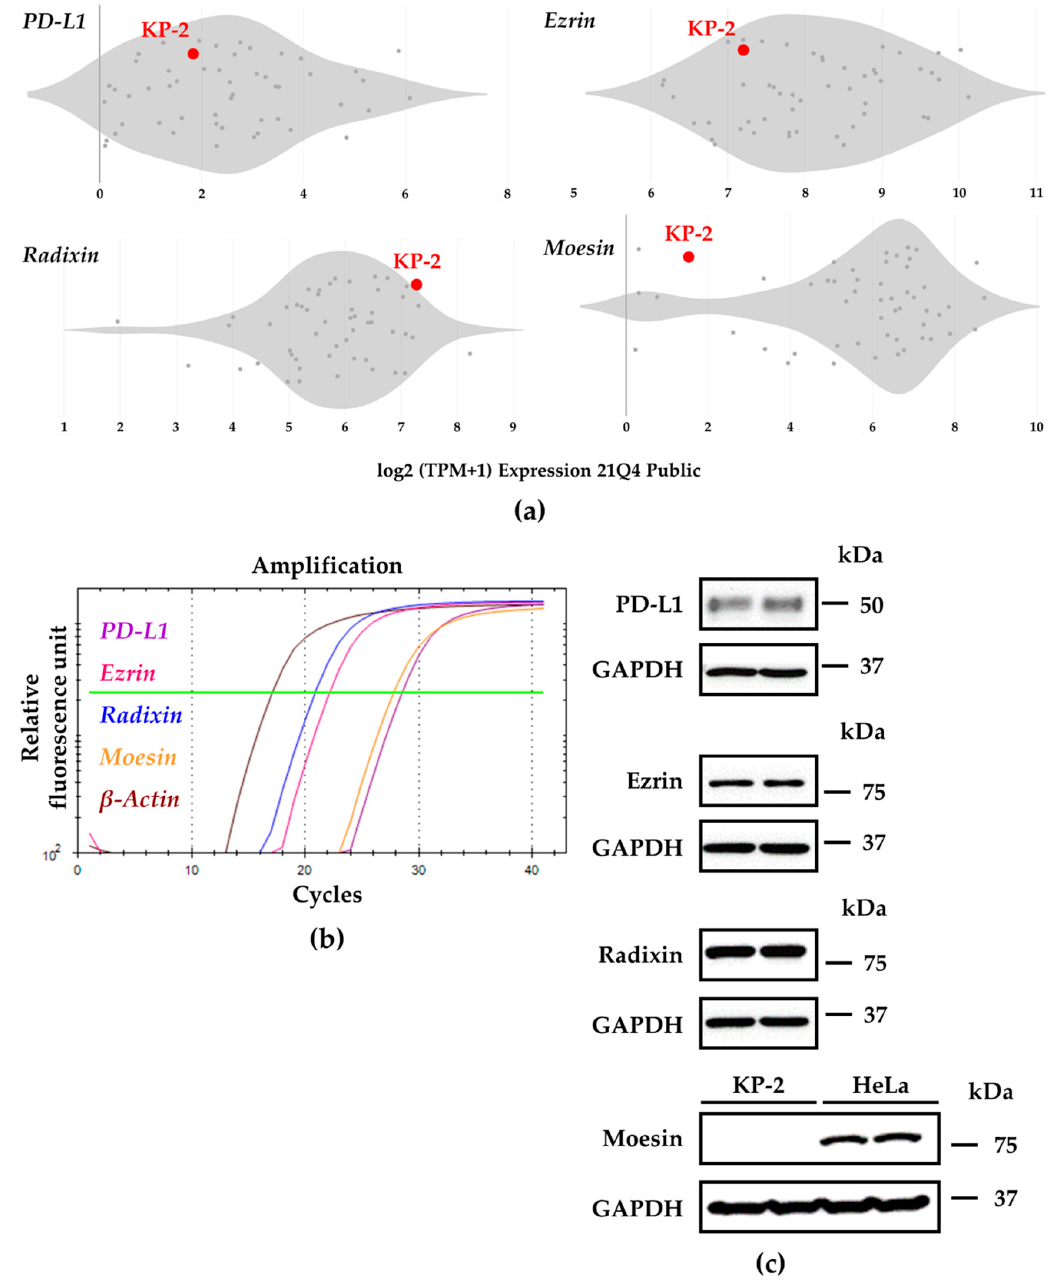
Figure 1. Gene and protein expression profiles of programmed death ligand-1 (PD-L1), ezrin, radixin, and moesin (ERM) in KP-2 cell. ( a ) Relative gene expression patterns of PD-L1 and each ERM in various types of human pancreas cell lines evaluated by utilizing the Cancer Dependency Map (DepMap), Broad (2021): DepMap 21Q4 Public. Scatter plots show the expression levels (log2 (TPM + 1)) of four genes of interest in each human pancreas cell line. ( b ) Representative amplification curves of relative PD-L1 (purple line), ezrin (pink line), radixin (blue line), and moesin (orange line) as well as β -Actin (brown line) mRNA expressions in KP-2 cells as determined by real-time reverse transcription-polymerase chain reaction. ( c ) Representative images of western blots for detection of PD-L1, ezrin, radixin, moesin, and glyceraldehyde-3-phosphate dehydrogenase (GAPDH) proteins in whole-cell lysates of KP-2 cells. HeLa cells were included as positive control in which moesin protein is abundantly expressed. Molecular weights are indicated in kDa. The data are representative of three independent experiments using at least three independent samples of total RNA and protein extracts.